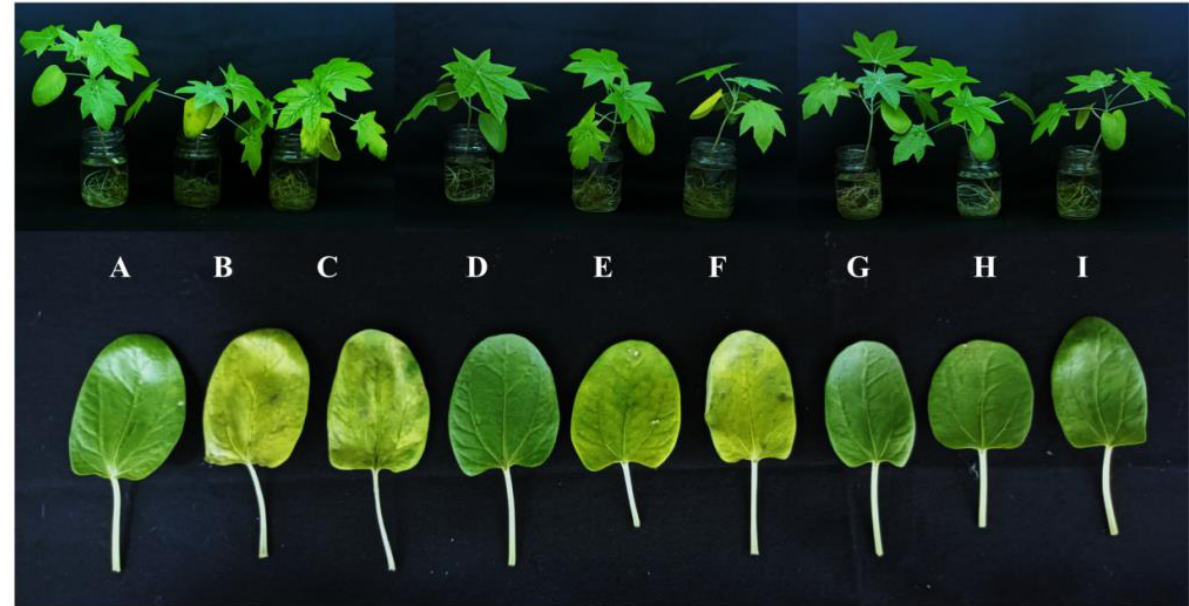
Figure 1. The phenotypic changes of cotyledonary leaves in R. communis after 6 day of exposure to CuSO 4 (80 and 160 µM) and cytokinin (KIN and BAP) treatments in Hoagland’s nutr ient medium. A: Control; B: 80 µM CuSO 4 ; C: 160 µM CuSO 4 ; D: KIN; E: 80 µM CuSO 4 + KIN; F: 160 µM CuSO 4 + KIN; G: BAP; H: 80 µM CuSO 4 + BAP; and I: 160 µM CuSO 4 + BAP.